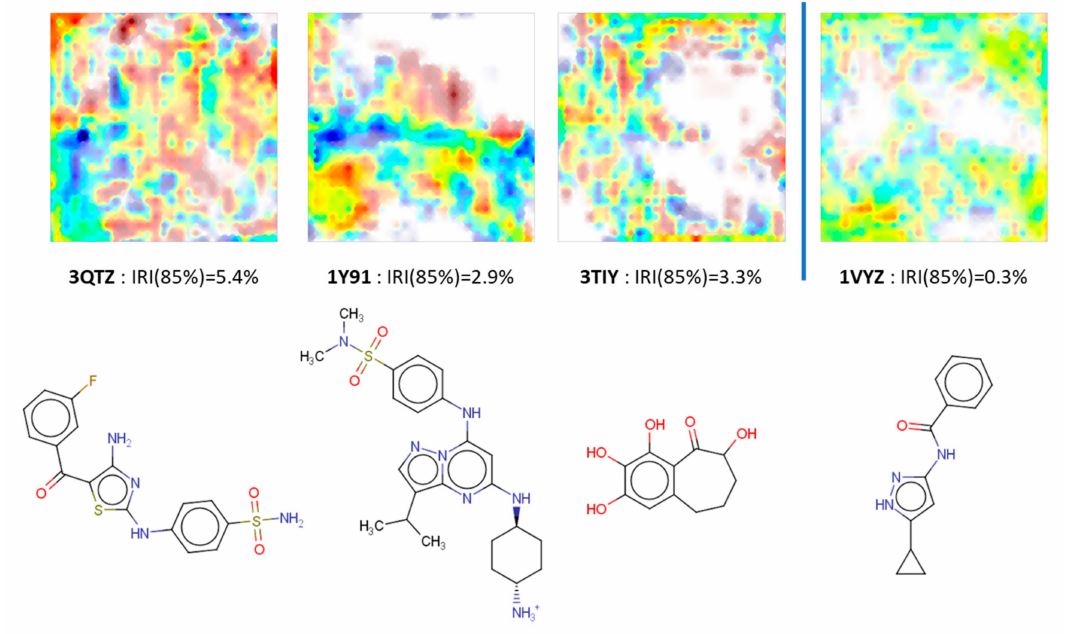
Figure 4. Ligands most and respectively (right-hand) least prone to fail visiting the entire conformational space during one docking run (as described in Methods). Fuzzy class landscapes based on the CF map highlight in extreme colors dark red or dark blue the CS zones visited by only one of the two repeated docking runs, whilst intermediate colors denote zones into which both runs found conformers. Transparency of the color is gradually increasing in less populated zones, producing the white spots in the “empty” zones, corresponding to site-ligand interaction patterns never observed for the given ligand. See Methods for the definition of the Irreproducibility Index